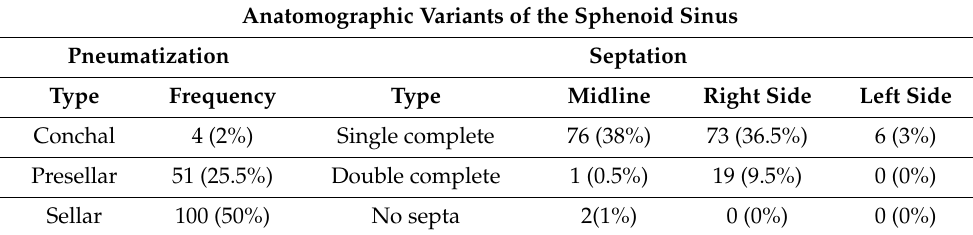
Table 2. Incidence of sphenoid sinus pneumatization and septation in the Ethiopian population.